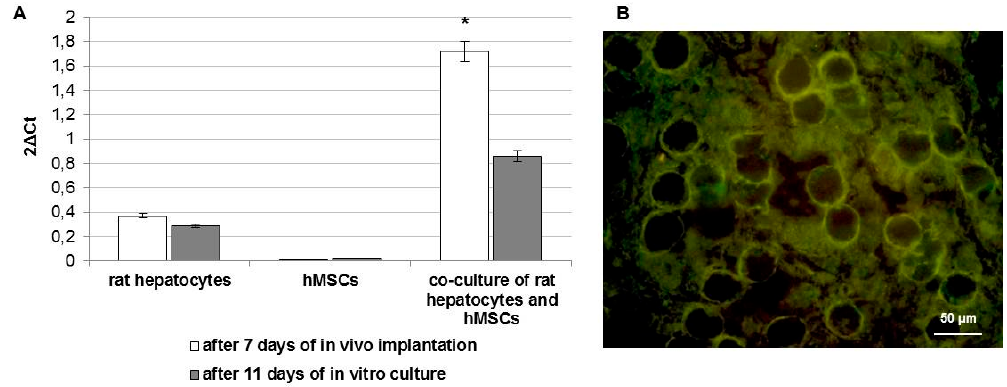
Figure 4. ( A ) Rat albumin mRNA in pocket-scaffolds derived from 3D mono-culture of rat hepatocytes, 3D mono-culture of hMSCs, or 3D co-culture of rat hepatocytes and hMSCs at day seven from implantation in a rat model (white bars) and at day 11 of in vitro cultures (gray bars). Results are related to nine rats that have received the three different experimental settings. Data presented as the mean ± standard error of three measurements. * p value ≤ 0.05; ( B ) IF staining of rat albumin (green) in pocket-scaffold (black) enriched with rat hepatocytes and hMSCs at seven days from implantation in a rat model.